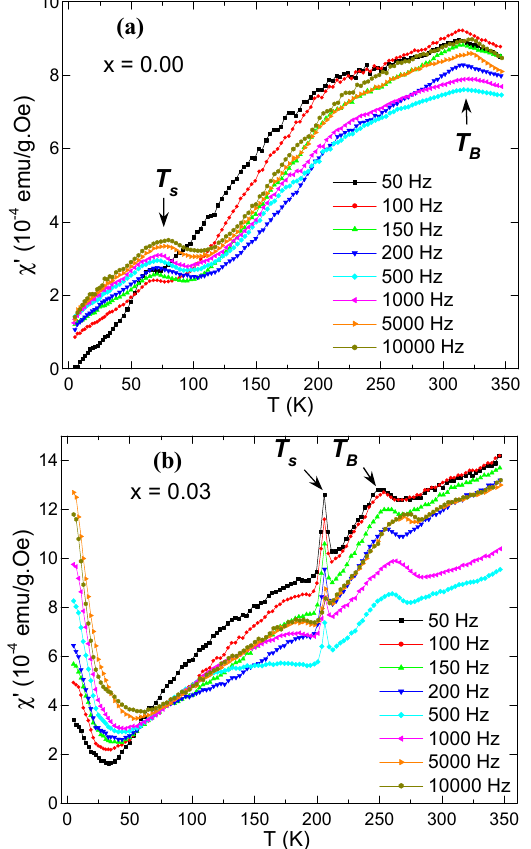
Figure 7. χ (cid:48)(cid:48) ( T ) curves for ( a ) NiFe 2 O 4 and ( b ) NiFe 1.97 Dy 0.03 O 4 Figure 7. 𝜒′′(𝑇) curves for ( a ) NiFe 2 O 4 and ( b ) NiFe 1.97 Dy 0.03 O 4 NPs